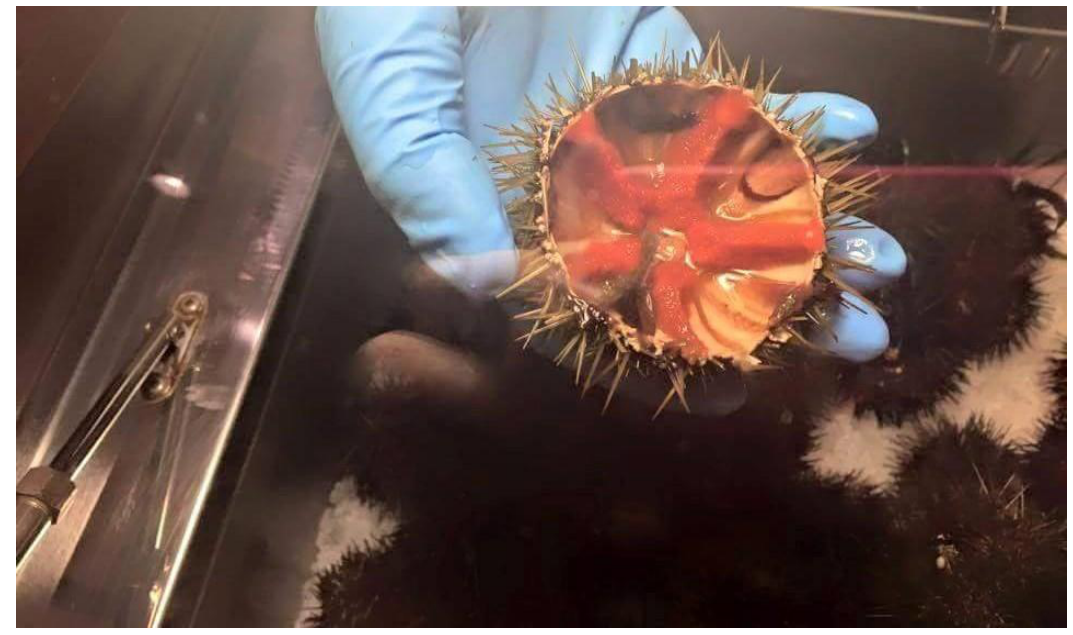
Figure 1. Opening of the sea urchin shells.